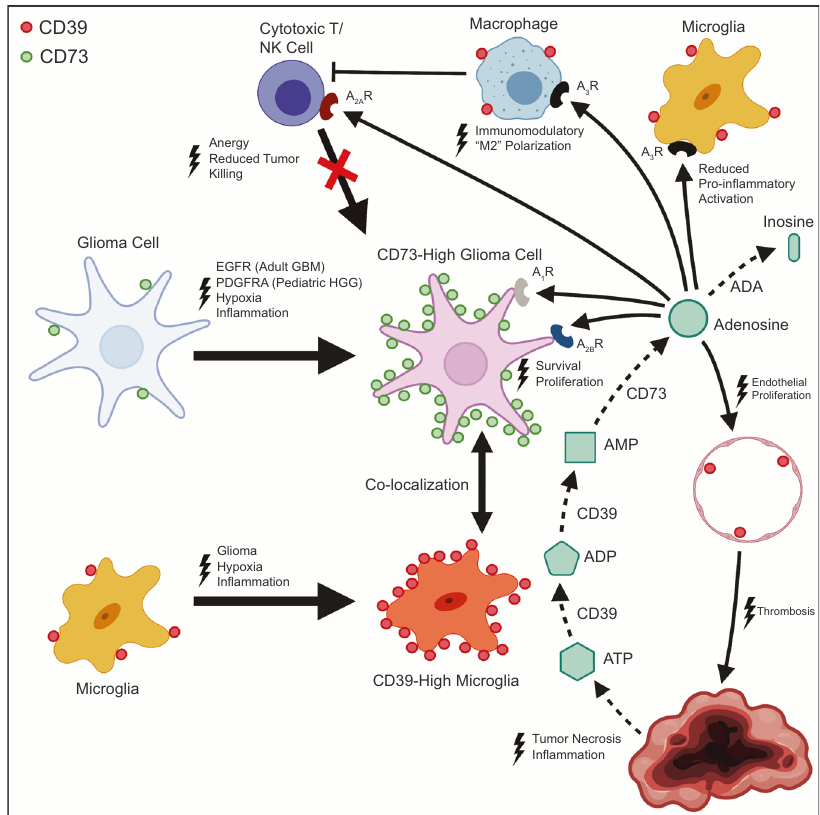
Fig. 9 | Spatial topography of purine signaling in glioblastoma and pediatric high-grade glioma. Collectively, data suggests a model in which EGFR activation (adultIDH-WTglioblastoma), PDGFRA activation(pediatrichigh-gradeglioma)and/ or hypoxia promote CD73 expression by tumor cells in an in fl ammatory